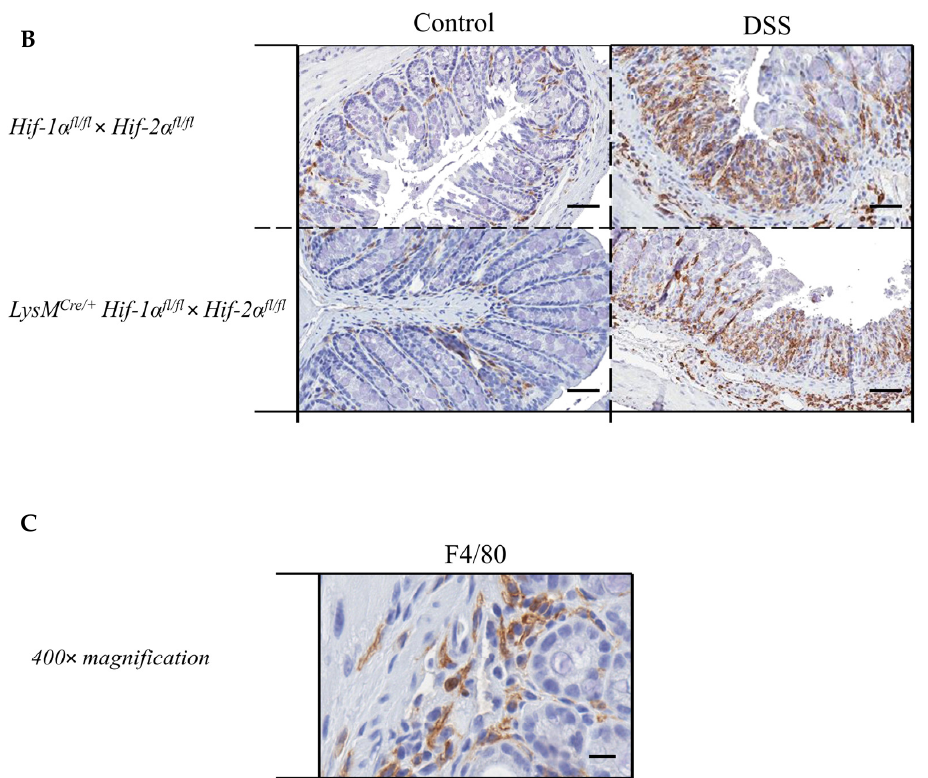
Figure 5. Macrophages without functional HIF-2 α showed a similar migration pattern compared to wildtype cells. Exemplary presentation of F4 / 80-stained colon tissue sections of ( A ) Hif-2 α fl / fl , LysM Cre / + Hif-2 α fl / fl and LysM Cre / Cre Hif-2 α fl / fl animals, and ( B ) Hif-1 α fl / fl × Hif-2 α fl / fl and LysM Cre /+ Hif-1 α fl / fl × Hif-2 α fl / fl animals with and without DSS treatment and an exemplary high-resolution image that shows the specificity of the staining ( C ). After DSS treatment, increased numbers of F4 / 80-positive cells were observed in the lamina propria mucosae and tela submucosa in all tissue sections. ( A ): n (Control) = 3 ( LysM Cre / Cre Hif-2 α fl / fl ) / 5 ( Hif-2 α fl / fl , LysM Cre / + Hif-2 α fl / fl ), n (DSS) = 8 ( LysM Cre / Cre Hif-2 α fl / fl ) / 12 ( Hif-2 α fl / fl , LysM Cre / + Hif-2 α fl / fl ); (B): n (Control) = 7, n (DSS) = 14. ( A ) and ( B ): magnification 200 × , scale bar: 100 µ m; ( C ): magnification 400 × , scale bar: 50 µ